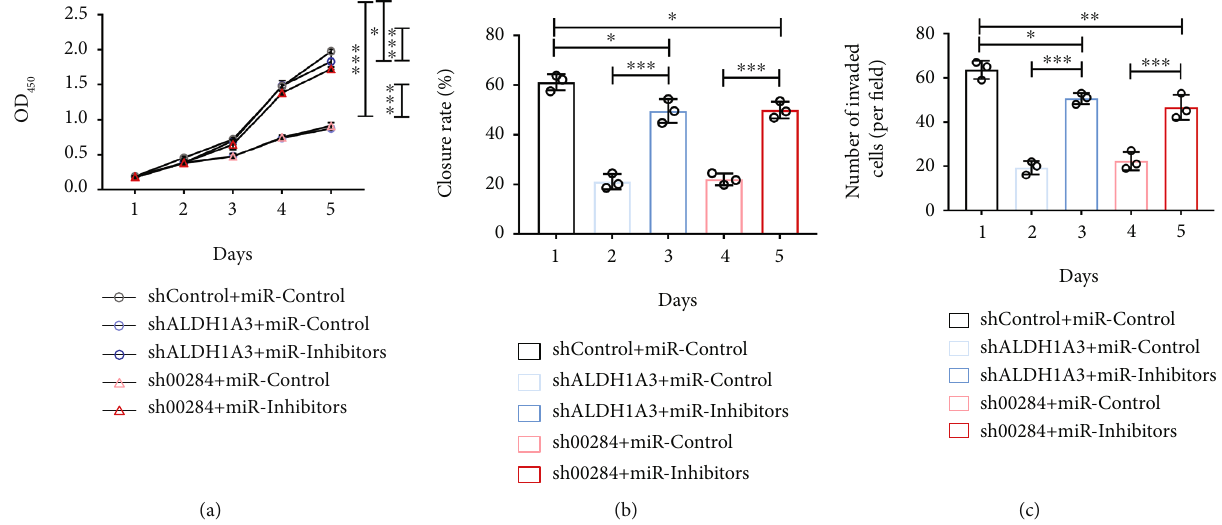
Figure 7: Inhibition of miR-361-5p rescued the e ff ect ALDH1A3 or Linc00284 knockdown in CRC cells. The e ff ect of miR-361-5p treatment on cell viability (a), migration (b), and invasion (c) of ALDH1A3- or Linc00284-silenced SW480 cells was evaluated by CCK-8 assay, wound healing assay, and trans-well assay, respectively (3 wells per